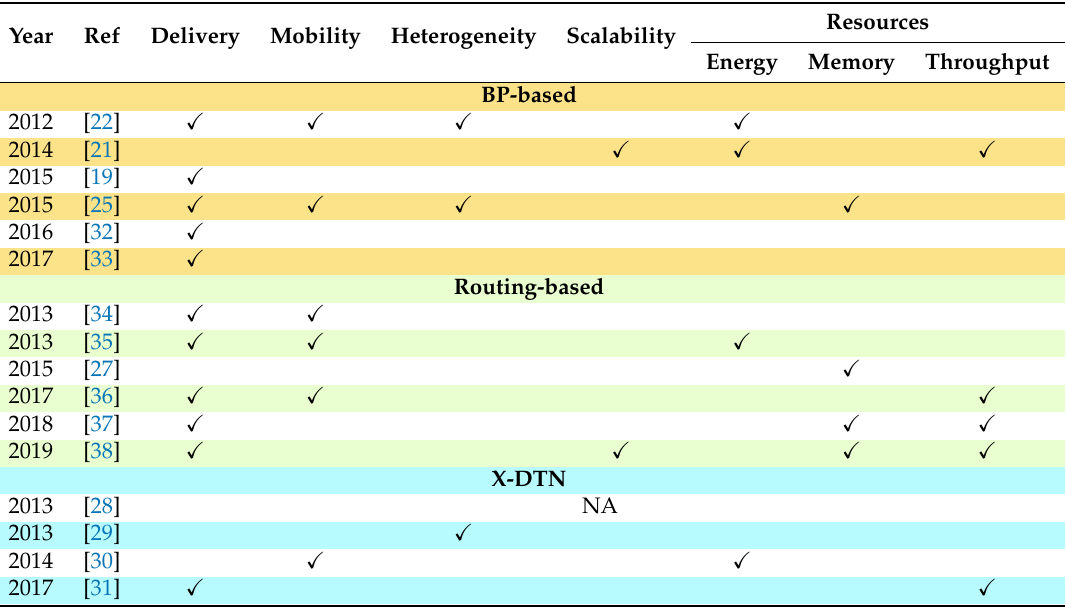
Table 2. Comparison of different DTN solutions for